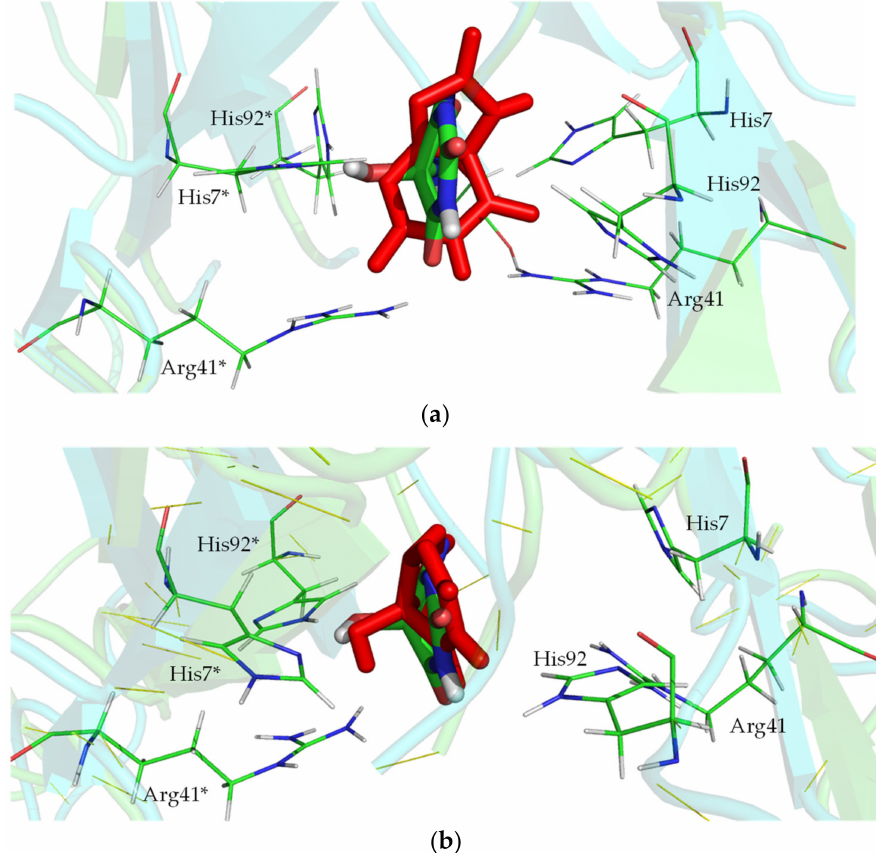
Figure 4. Overlaying 5-HIU of complex 1 (colored with red) with complex 2 (colored by elements) along their MD trajectories: ( a ) the initial structures; ( b ) the final